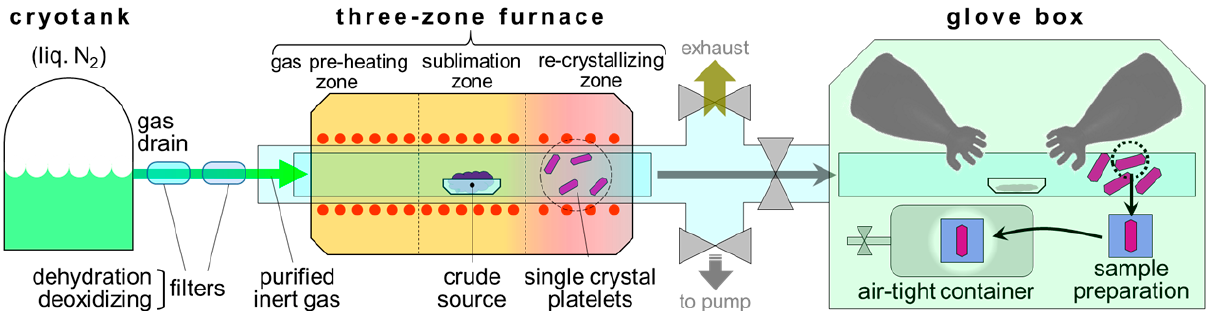
Figure 1. Schematic drawing of a PVT apparatus for fabrication of high-purity organic semiconduc- tor single-crystal substrates. single-crystal